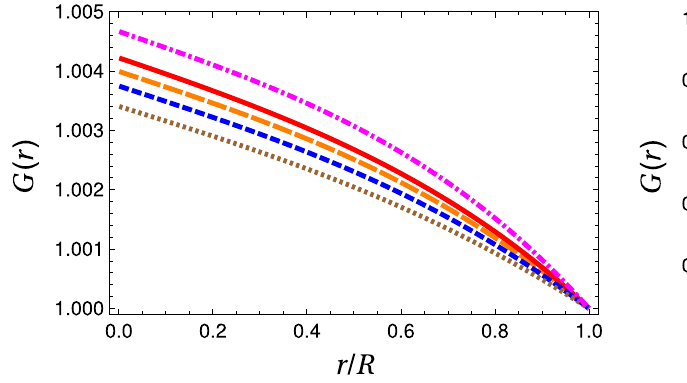
Fig. 3 Normalized anisotropic factor (cid:5)/ρ s vs dimensionless radial coordinate r / R for the five plus five interior solutions obtained here. It starts from zero at the centre of the stars, but it does not have to vanish at the surface. Left: Solutions 1–5 corresponding to the case G (cid:5) ( r = 0 ) = − 0 . 0002 / km (Table 1). Shown are: (i) Solution 1 (solid